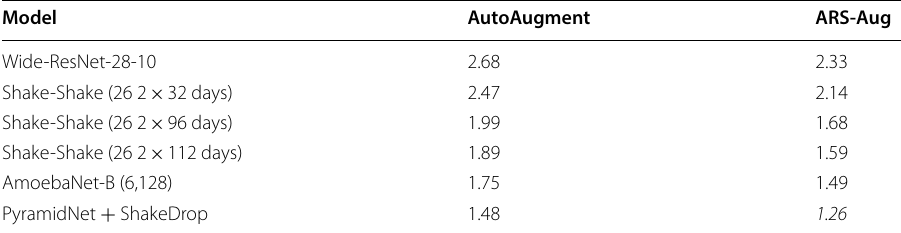
Table 9 The performance of ARS on continuous space vs. AutoAugment on discrete space [116]